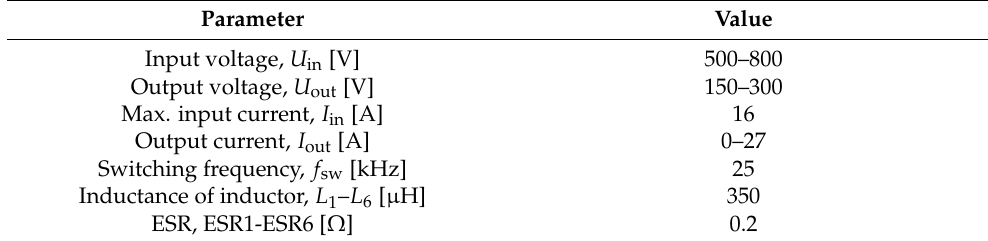
Table 3. DC/DC converter